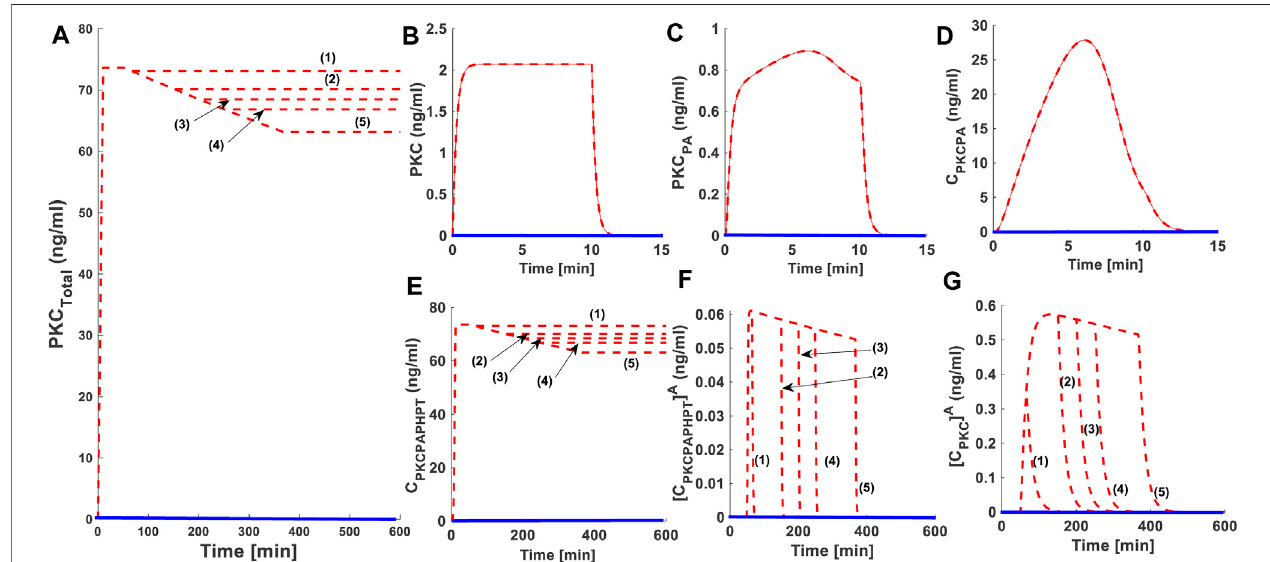
FIGURE3| Theeffectofsecondmessenger-modulatedactivationdurationonthelifecyclecharacteristicsofPKC.Here,solidredlinesindicatestimulation(protein synthesis as well as second messenger) and blue solid line indicate non-stimulated condition. These results show that during lower intensity second messenger stimulation increasing the duration of pulse can in fl uence the life cycle characteristics of enzyme. However, the degree of this in fl uence is not signi fi cant. (A) Total PKC enzymeduring protein synthesis and second messengermediatedstimulation.Theseresults show thatapplicationofabriefpulse protein synthesispulse (10 min) shows the quick generation of cPKC enzyme and stabilization. These results also show that at later time point (i.e., 50 min) the application of a lower intensity second messenger pulse (15-min pulse mimicking Ca +2 /DAG generation; DAG = 0.0005 nM) leads to the activation, termination, down-regulation and restoration of cPKC enzyme. These results high-light that cPKC signaling characteristics are only moderately in fl uenced by the duration of second messenger pulse. Here, fi ve different durations of pulse stimulation are used i.e., second messenger DAG pulse stimulation set at 15 min (dashed red line (1)); 100 min (dashed red line (2)), 150 min (dashed redline(3)),200 min(dashedredline(4))and316.66 min(dashedredline(5))(fromshortertolongerdurationperiods).Theseresultselucidatethatatshorterpulseperiod i.e., 15 min degree of down-regulation is only minimum and at longest pulse period i.e., 316.66 min the degree of down-regulation is only moderate. (B) The concentrationofnaïve,newlysynthesizedunstableformofcPKC. (C) Theconcentration ofPKCspeciesphosphorylated atactivationsite. (D) Theconcentration ofPKC complex C.PKC.P A . (E) The concentration of PKC complex, phosphorylated at all three sites i.e., activation, turn and hydrophobic sites. (F) The concentration of active complex PKC.P A .P H .P TA after second messenger binding. (G) Concentration of dephosphorylated but active PKC A molecule.